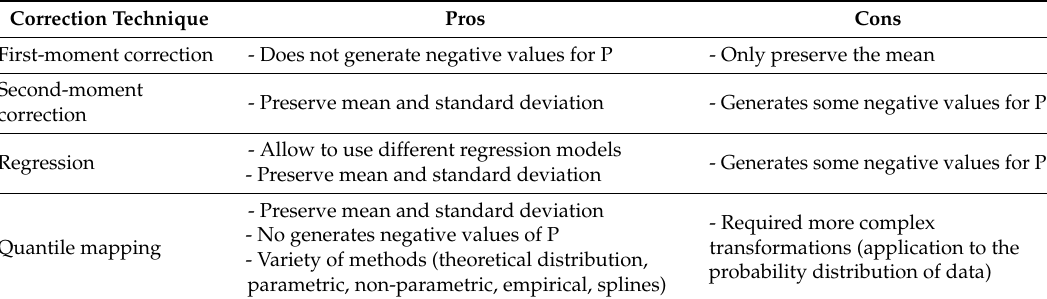
Table 1. Summary of advantages and disadvantages of each correction technique (P stands for precipitation). Correction